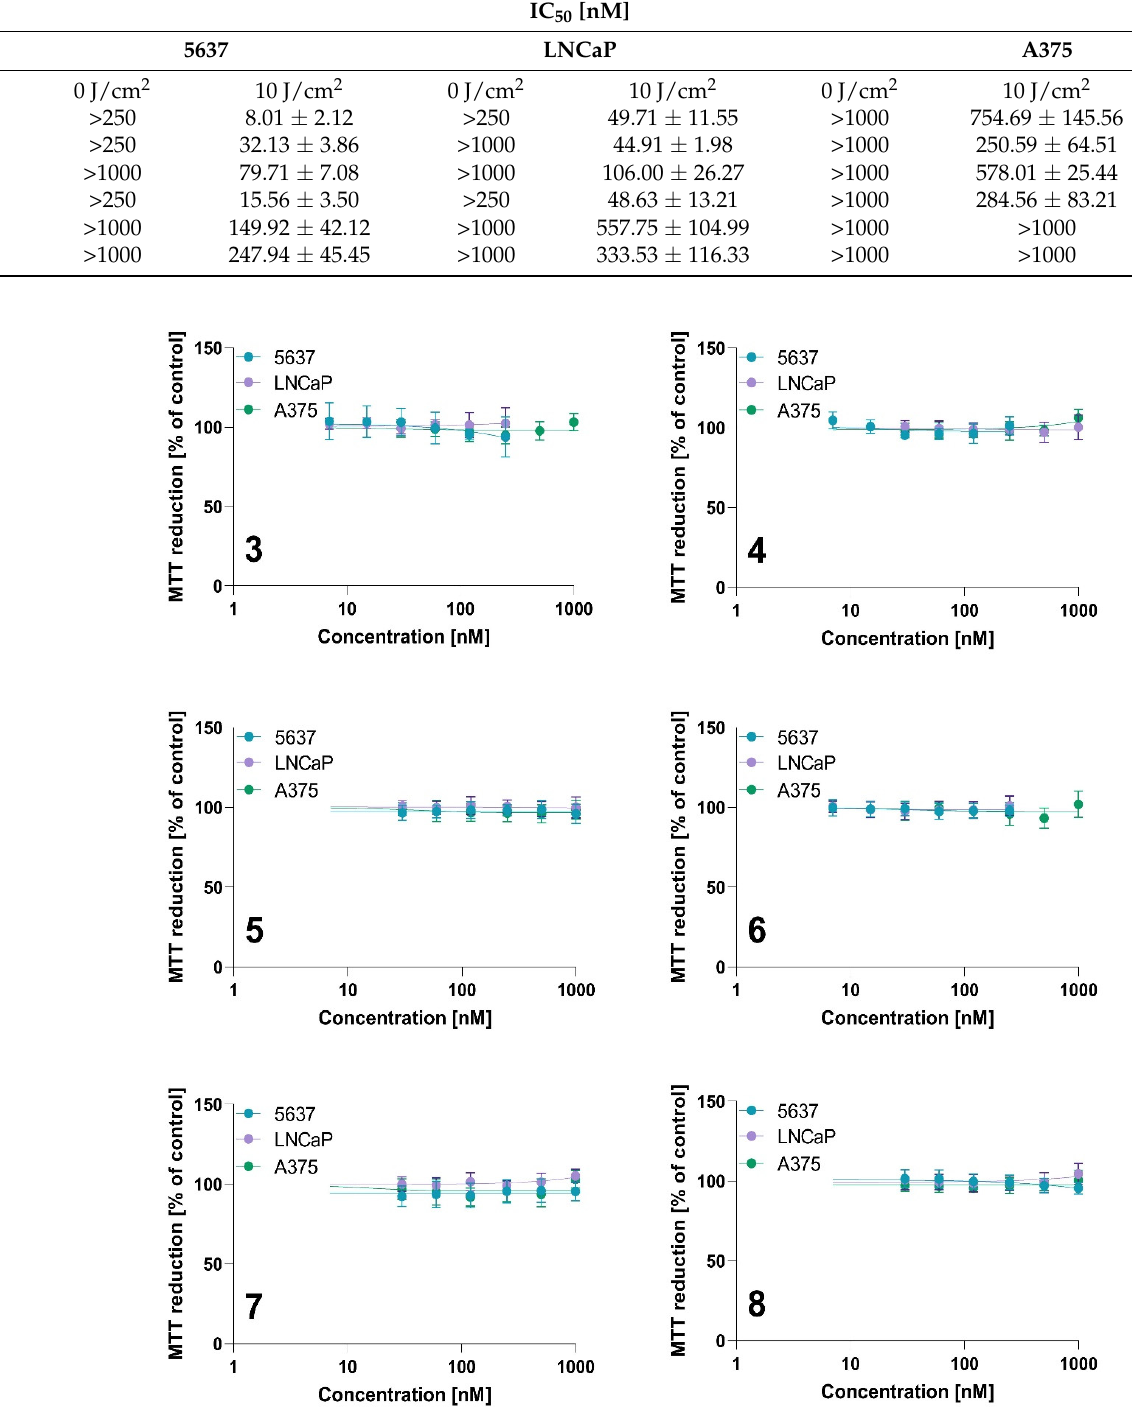
Figure 10. The dark toxicity of tested photosensitizers against 5637, LNCaP, and A375 cells for compounds 3 , 4 , 5 , 6 , 7 and 8 . Data are expressed as the mean ± SD from at least three independent experiments.